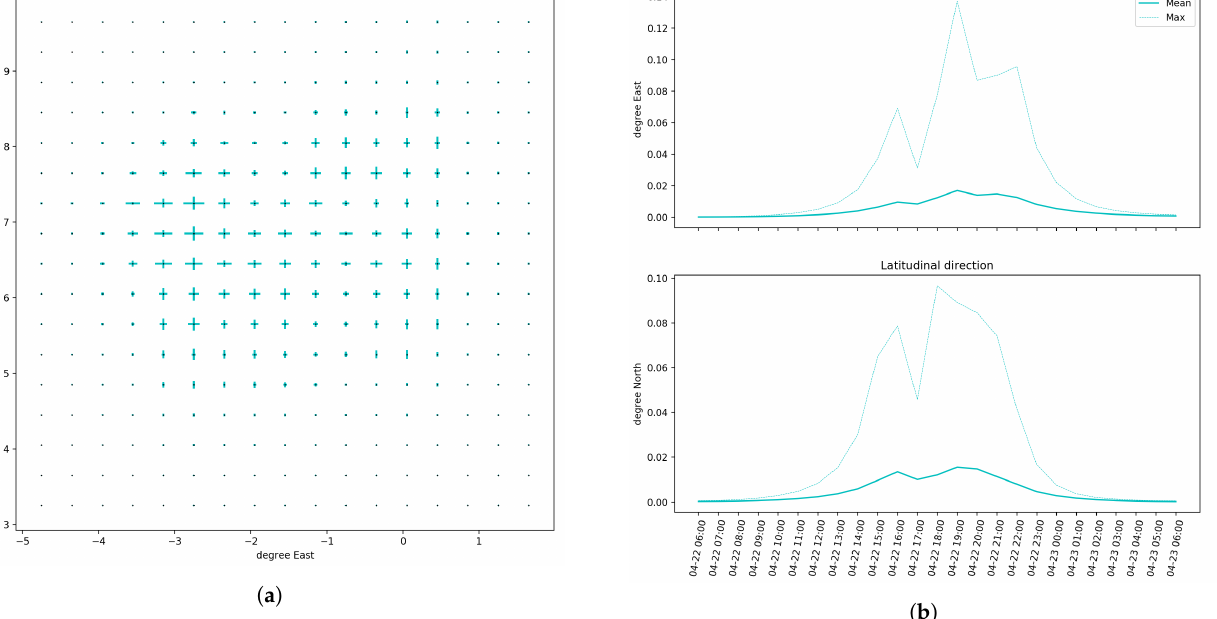
Figure 12. Standard deviation of the mappings in the LOOV experiment. ( a ) Maximum standard deviation at each grid point. ( b ) Mean and maximum standard deviation at each time